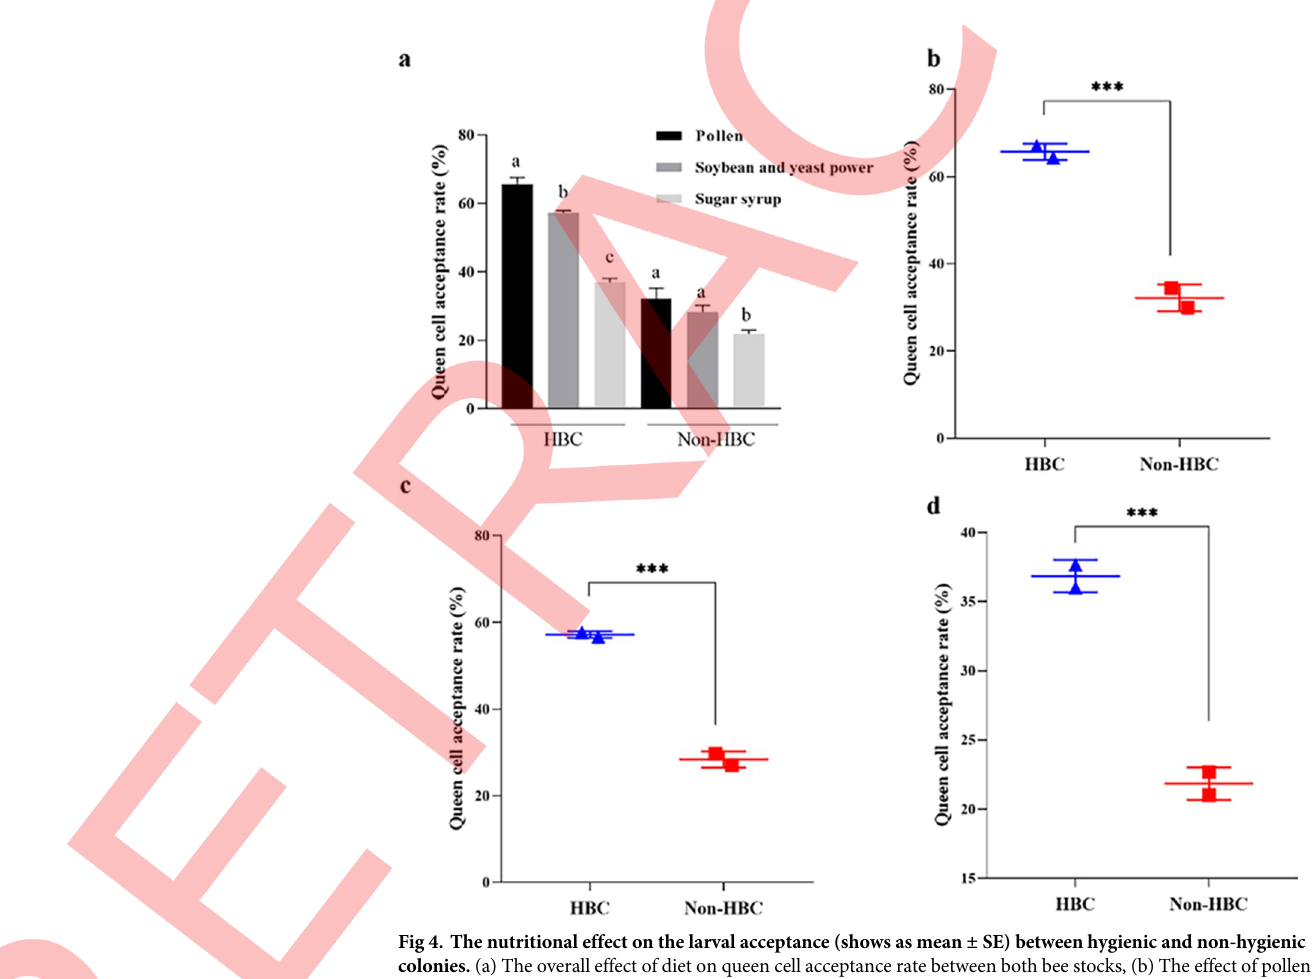
Fig 4. The nutritional effect on the larval acceptance (shows as mean ± SE) between hygienic and non-hygienic colonies. (a) The overall effect of diet on queen cell acceptance rate between both bee stocks, (b) The effect of pollen diet on queen cell acceptance rate between both bee stocks (c) The effect of pollen substitute diet on queen cell acceptance rate between both bee stocks (d) The effect of sugar syrup on queen cell acceptance rate between both